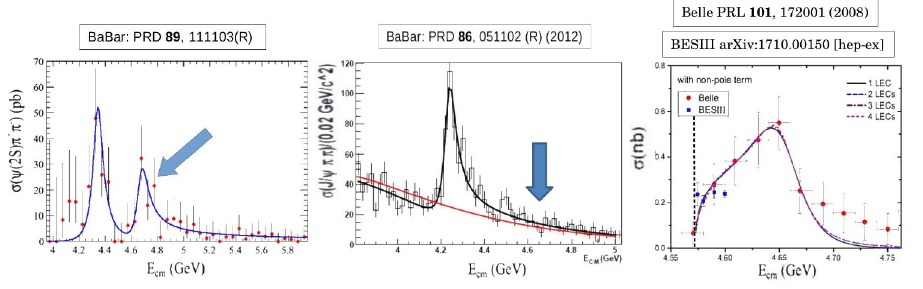
Figure 4. Cross section of the the Y (4660) process of interest: π + π − ψ (3686) on the left, π + π − J /ψ in the middle and Λ C Λ C on the